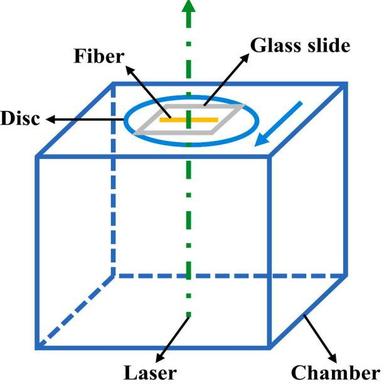
Schematic diagram of the characterization of the light-conducting properties of transparent fibers.